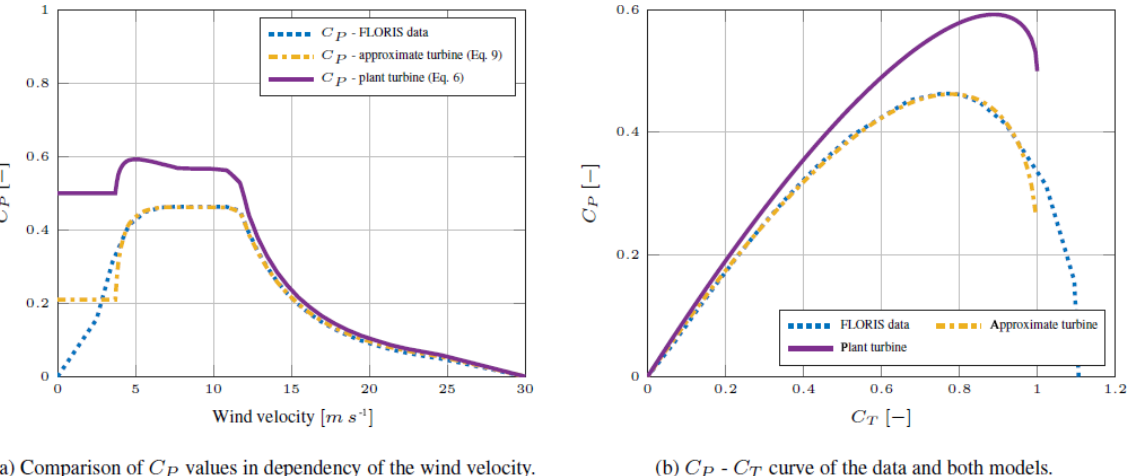
Figure 2. Comparison between data, the plant turbine and the approximate turbine model. The models give different connections between thrust and power